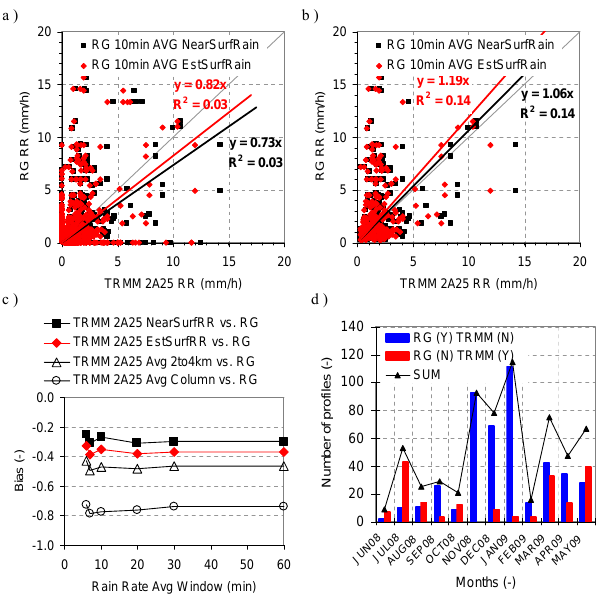
Fig. 4: Scatterplots for the comparison TRMM 2A25 surface rain rate and averaged rain gauge rain rates for the period 06/01/08-05/15/09: a) For all TRMM 2A25 surface rain rates and rain gauges records, b) For non null TRMM 2A25 surface rain rates and rain gauges records. Rain gauges rain rates are averaged using a 10-min scale centered at the time the satellite overpasses. c) Bias sensitivity as a function of the TRMM 2A25 rain product and rain gauge rain rate scale. d) Repartition of the number of hits/misses as a function of the month of the year.